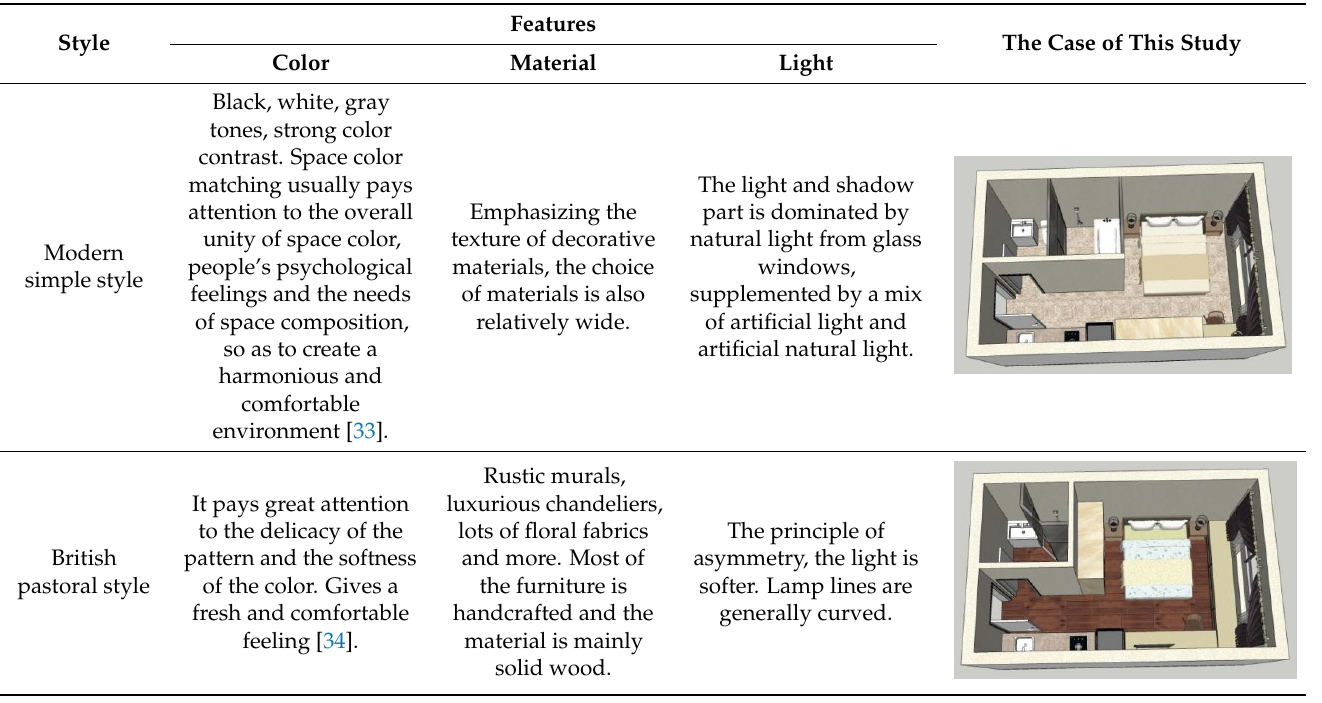
Figure 2. Location, room type map and plans of the case area. Source: bzdt.ch.mnr.gov.cn (accessed on 25 April 2022).